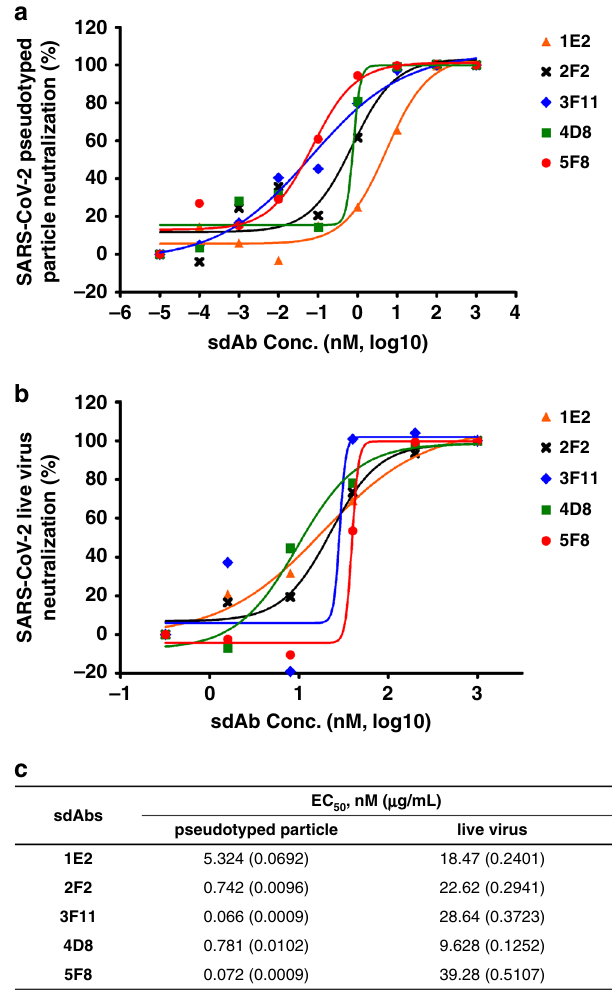
Fig. 2 Neutralization of SARS-CoV-2 by RBD-speci fi c sdAbs. a Neutralization of 5 sdAbs against SARS-CoV-2pp. SARS-CoV-2pp was pre-incubated with 5-fold serially diluted sdAbs before inoculation of human ACE2 transfected 293T cells. At 48 h post infection, luciferase activities were measured, and percent neutralization was calculated. The experiments were performed independently at least twice and similar results were obtained. One representative data of one experiment were shown and data were average values of three replicates ( n = 3).